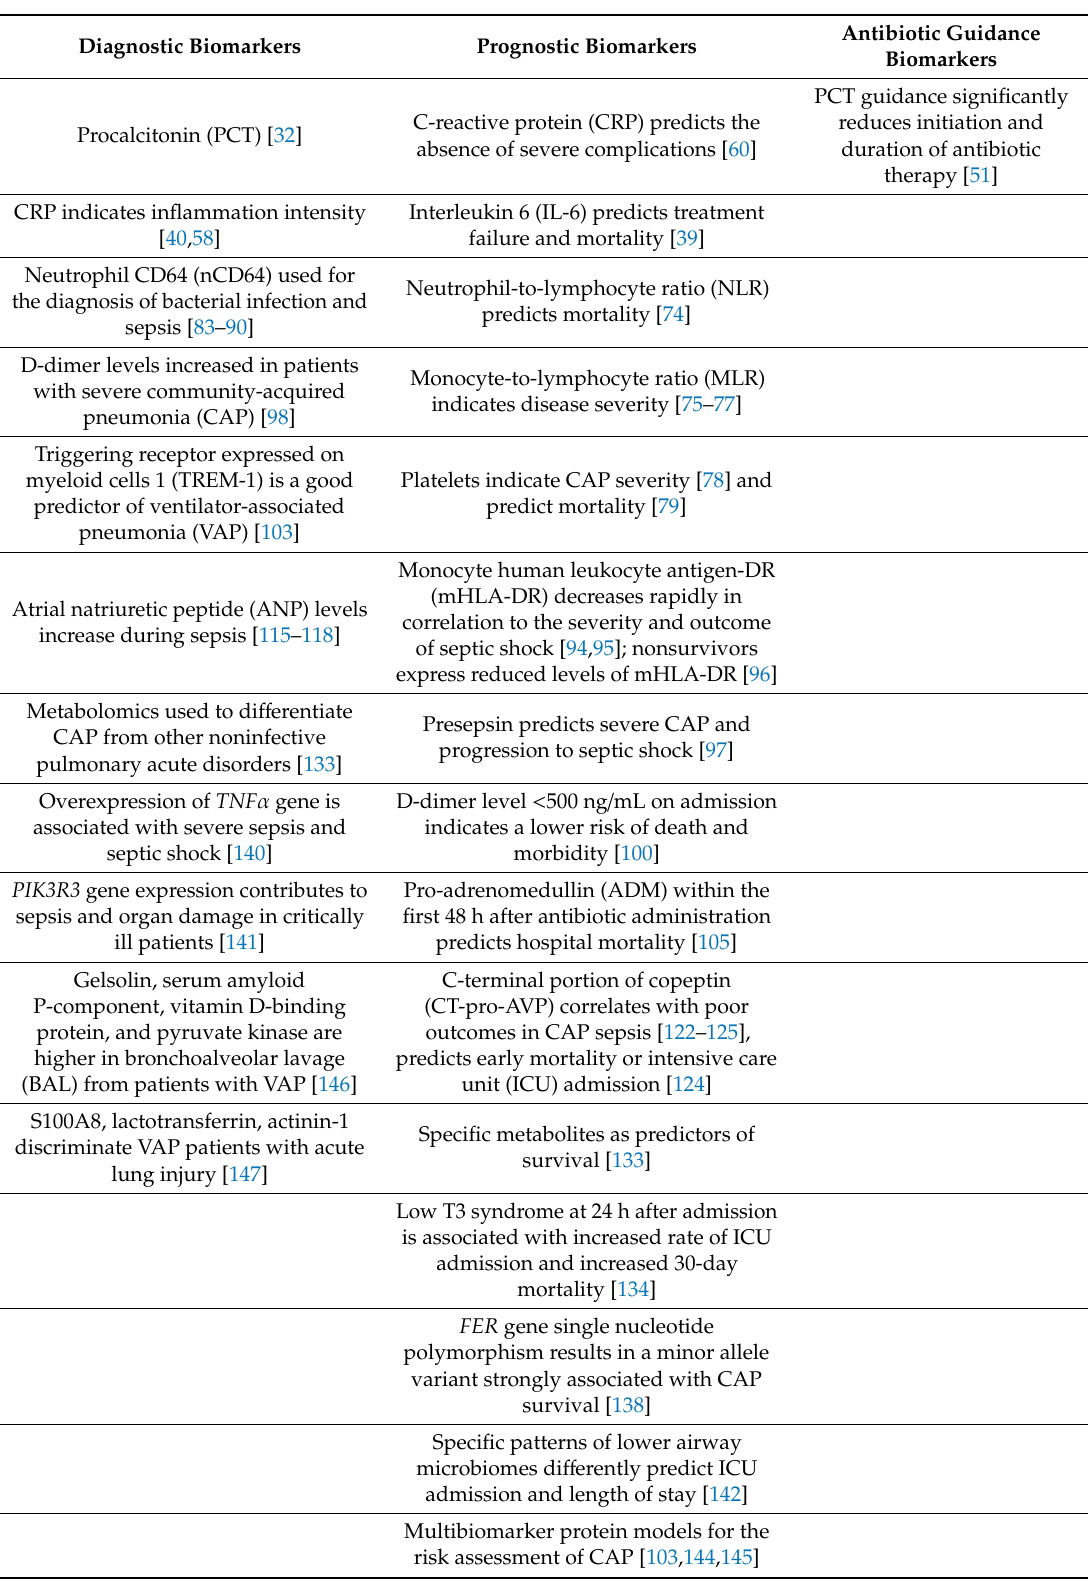
Table 1. Summary of diagnostic, prognostic, and antibiotic guidance biomarkers in pneumonia and their